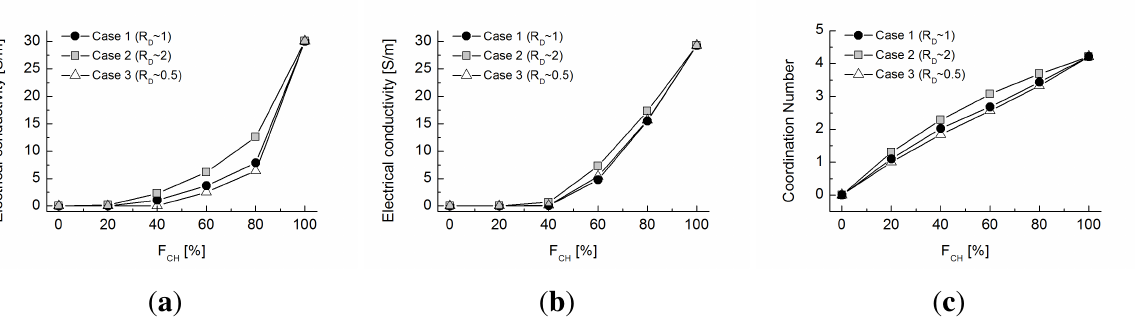
Figure 10. ( a ) Electrical conductivity values measured by two-point electrodes; ( b ) electrical conductivity values estimated by the network model; ( c ) coordination number estimated for virtual specimens with varying volumetric fractions of chrome balls for Cases 1 to